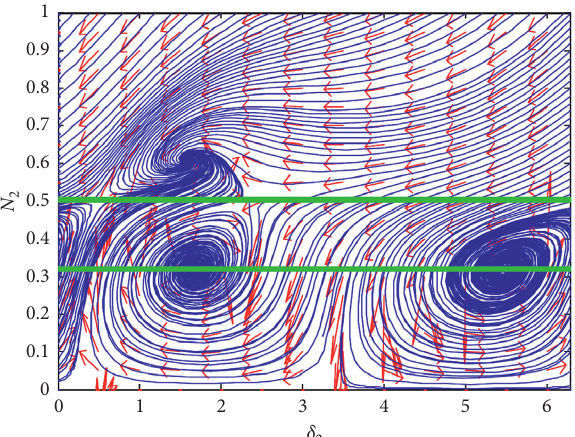
Figure 10: Phase portrait of nonlinear energy sink for the case � 0 . 8 ; λ � 0 . 3 ; kn � 5 ; f � λ 1 2